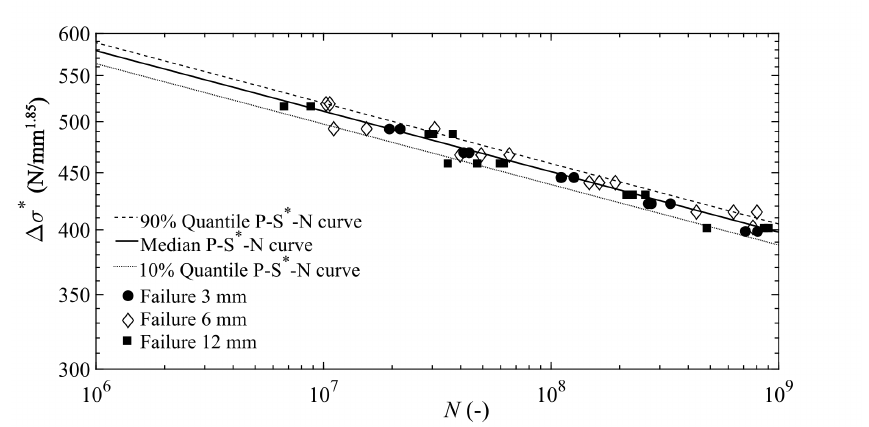
Figure 17. Fractal median P-S * -N curve in VHCF